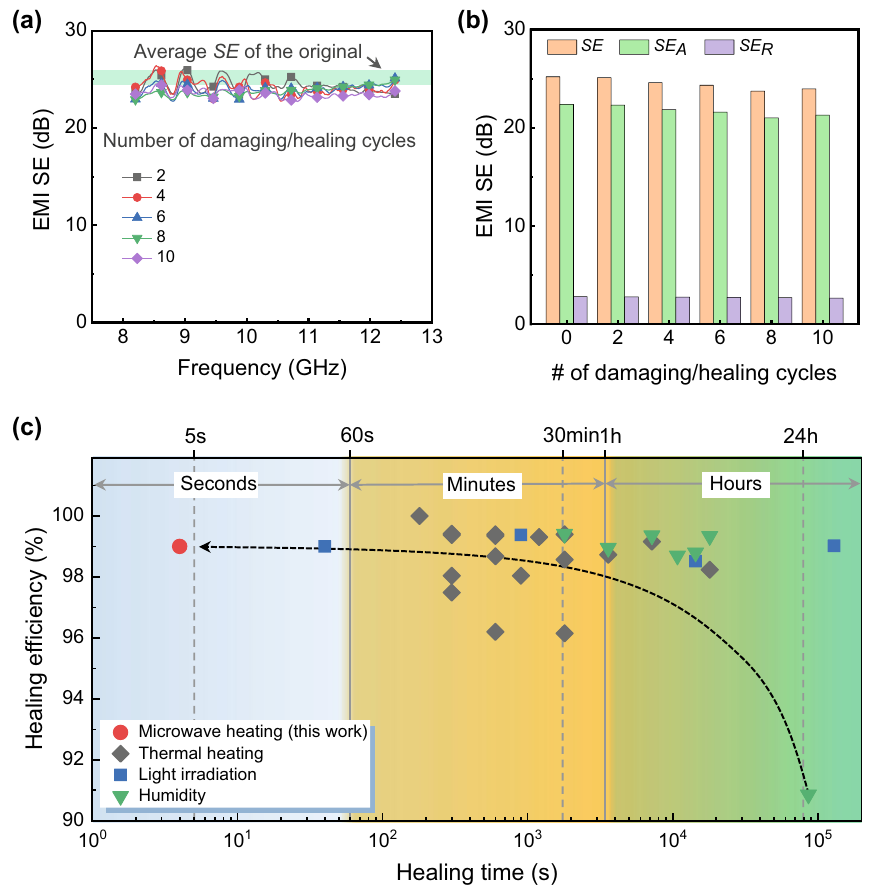
Fig. 6 Durable EMI shielding performance and comparison between various self-healing methods. a SE curves and b the corresponding SE R and SE A values at 10 GHz of PPy6@POTS fabric after various damaging/healing cycles. The shaded green area in a , as a guide for the eye, is the average SE of the original sample. c Comparison of healing efficiency and healing time of the PPy6@POTS fabric via the microwave heating approach with others reported in the literature. The microwave heating method stands out among the many other approaches due to its superfast healing process and comparable healing